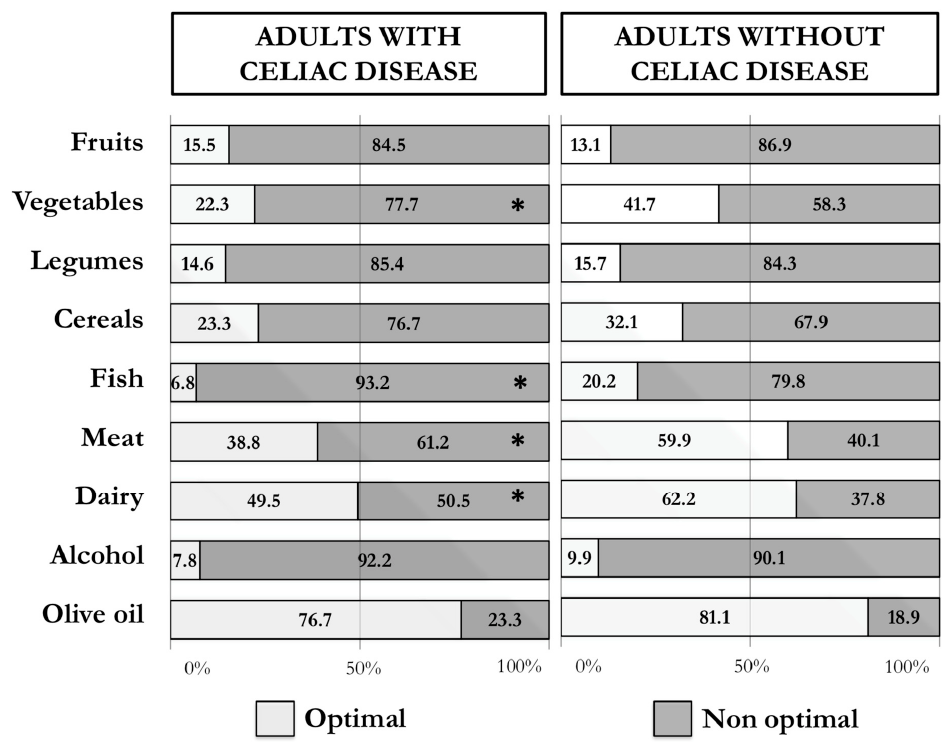
Nutrients 2023 , 15 , 938 Figure 1. Percentages of adults with and without celiac disease who reported an optimal (2 points) and non-optimal ( ≤ 1 points) intake of the single food groups of the Medi-Lite score (* p -value < 0.05).